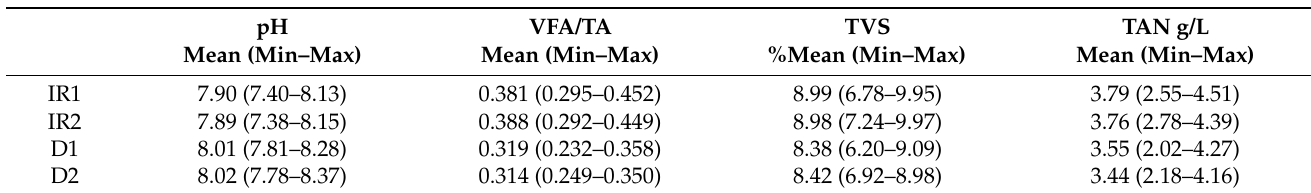
Table 4. Monitored parameters data of internal material of the two reactors (IR1 and IR2) and digestate (D1 and D2)